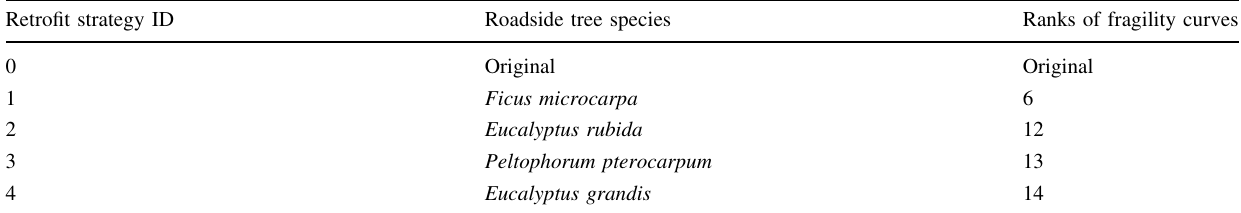
Table 6 Corresponding tree species of the set of retrofit strategies for the road network on Hainan Island Retrofit strategy